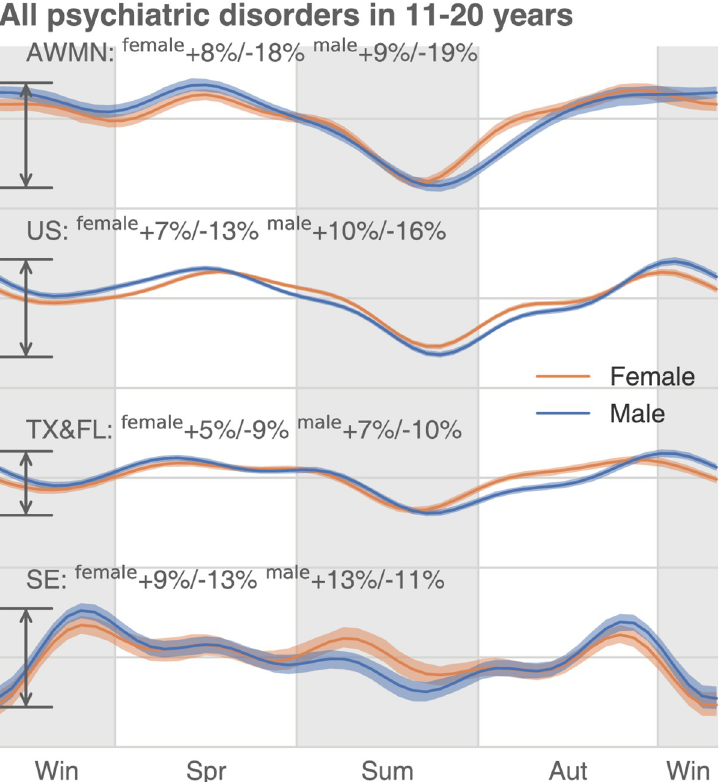
Fig 8. The corrected seasonality of all psychiatric disorders in 11 to 20 year olds across 4 regions. In the US, the annual oscillation of psychiatric disease DR is larger in the high-latitude areas (AK, WA, MT, ND, or AWMN) than in the low-latitude areas (TX and FL). The data underlying this figure can be found in https://doi.org/10.5061/dryad. vdncjsxv6. AK, Alaska; A AU : PleasedefineAWMNintheabbreviationlistofFig 8 ifapplicable = appropriate : WMN, Alaska, Washington, Montana, North Dakota; DR, diagnosis rate; MT, Montana; ND, North Dakota; WA,